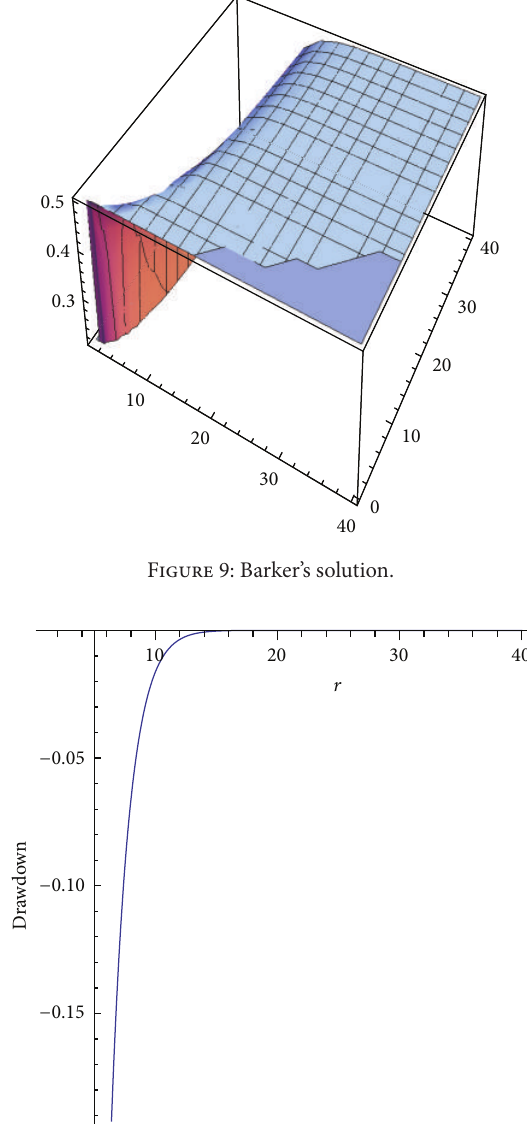
Figure 10: Solution of (30) as function of space (piezometric